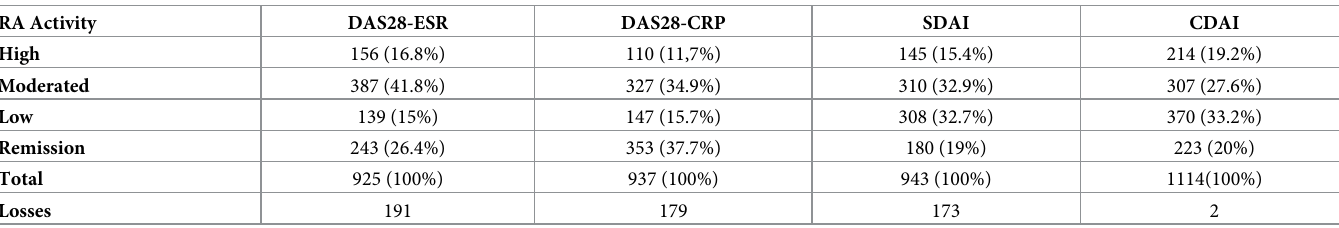
Table 4. Classification of disease activity according to composite indices.